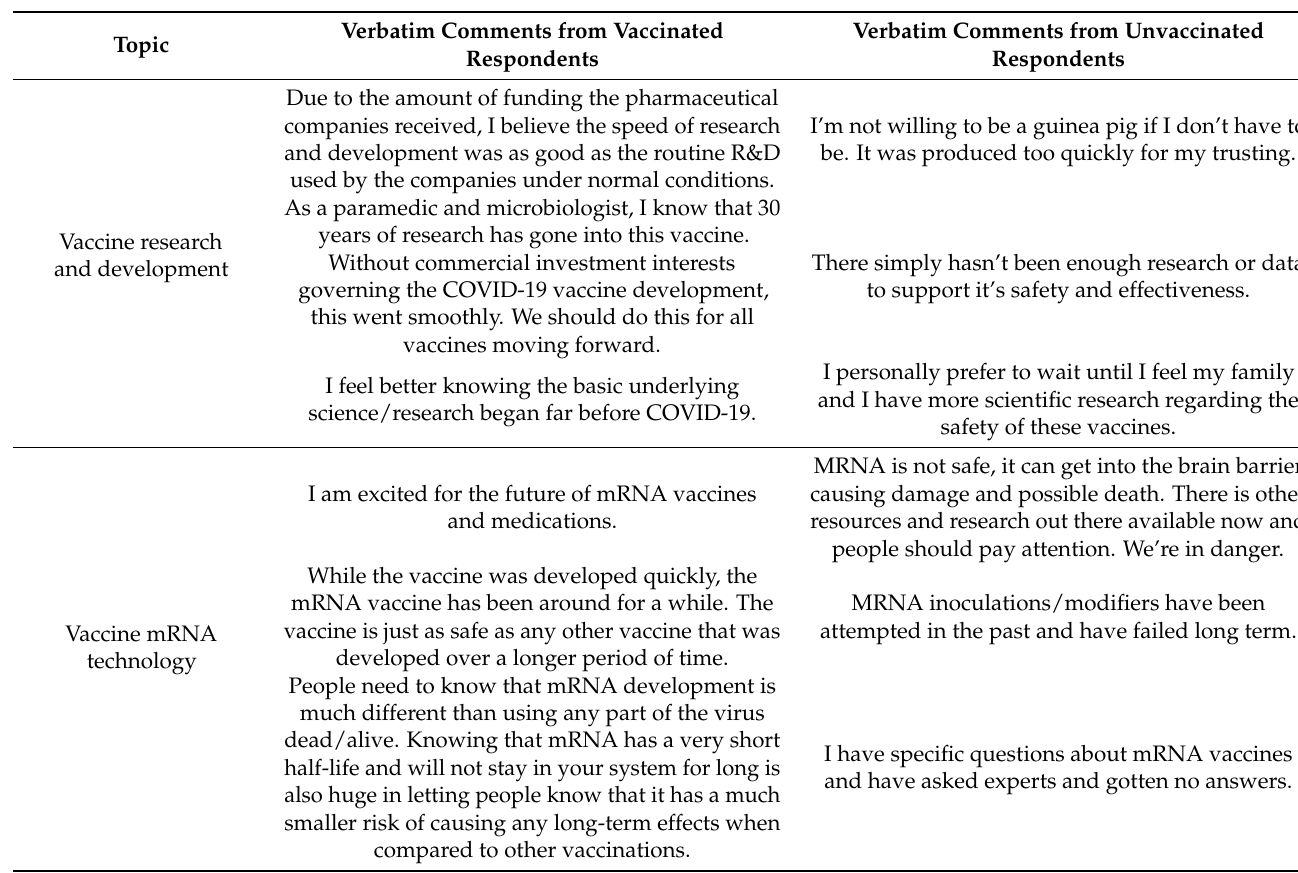
Table 3. Perspectives about vaccine